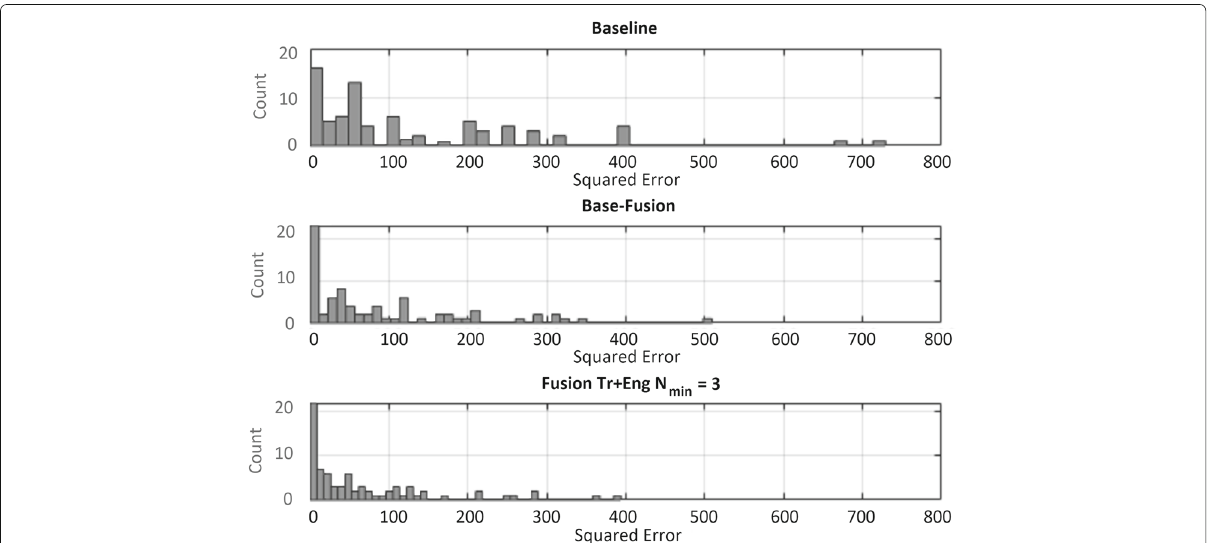
Fig. 6 Distribution of squared errors for the baseline MRMR case is shown in the top figure for the Turkish task. The middle figure shows the squared error distribution for the baseline MRMR case after fusion. Bottom figure shows the squared error distribution of the ml-MRMR system with N min = 3 with English and after